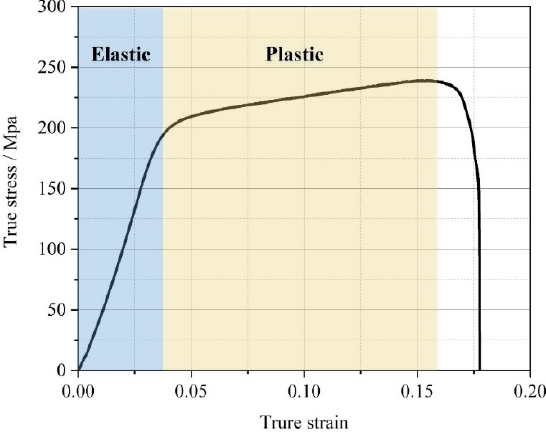
Figure 4. The compression test of cold-spray materials: ( a ) The specimens without shot peening; ( b ) the compression test.